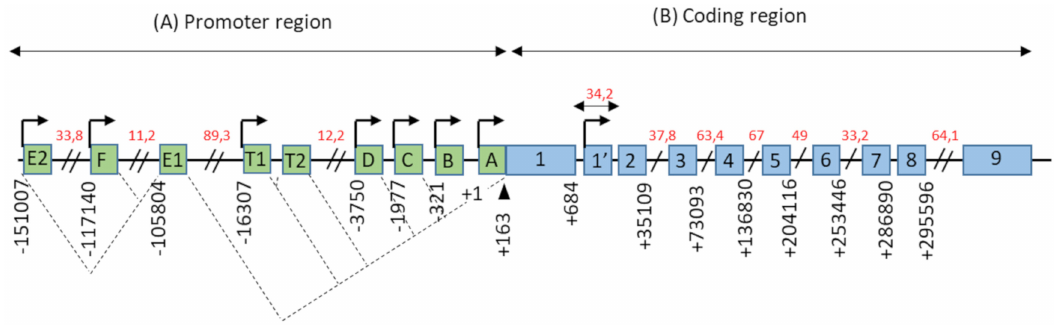
Figure 1. Genomic organization of the ESR1 gene. ( A ) The promoter region of the ESR1 gene contains 9 non-coding exons (green boxes), annotated from A to F—T1, T2, and 7 alternative promoters each having its own TSS (arrows). There is also a splice acceptor site located at position + 163 bp. The dotted lines symbolize the di ff erent possibilities for the splicing of non-coding exons, as described in the literature. Exons E1 and T2 expression depends on the promoters E2 and T1, respectively. ( B ) The coding region of the ESR1 gene consists of 10 exons (blue boxes), numbered from 1–1 (cid:48) to 9, separated by 9 introns. There is also an 8th alternative promoter located at the level of exon 1 (cid:48) . In this schematic representation, the scale is not respected but some estimated positions are indicated below the exons, in base pairs (bp). Position + 1 corresponds to the first transcription initiation site (TSS) described by Greene and colleagues, in 1986 [2]. The indications in red correspond to the length of long intronic regions in kilo base pairs (kbp). Adapted from